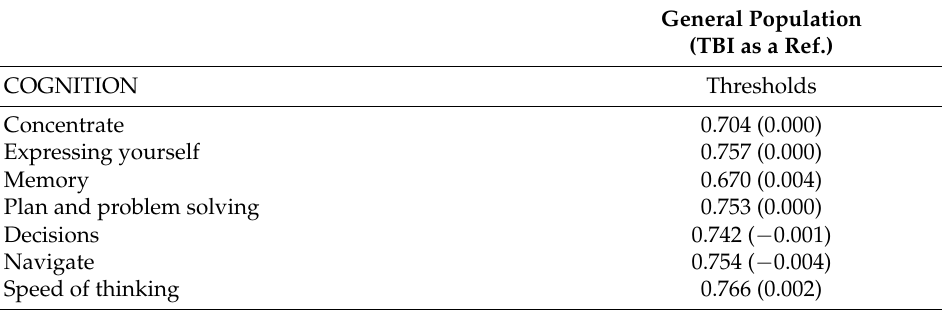
Table A2. Response probabilities estimated for general population sample from the full